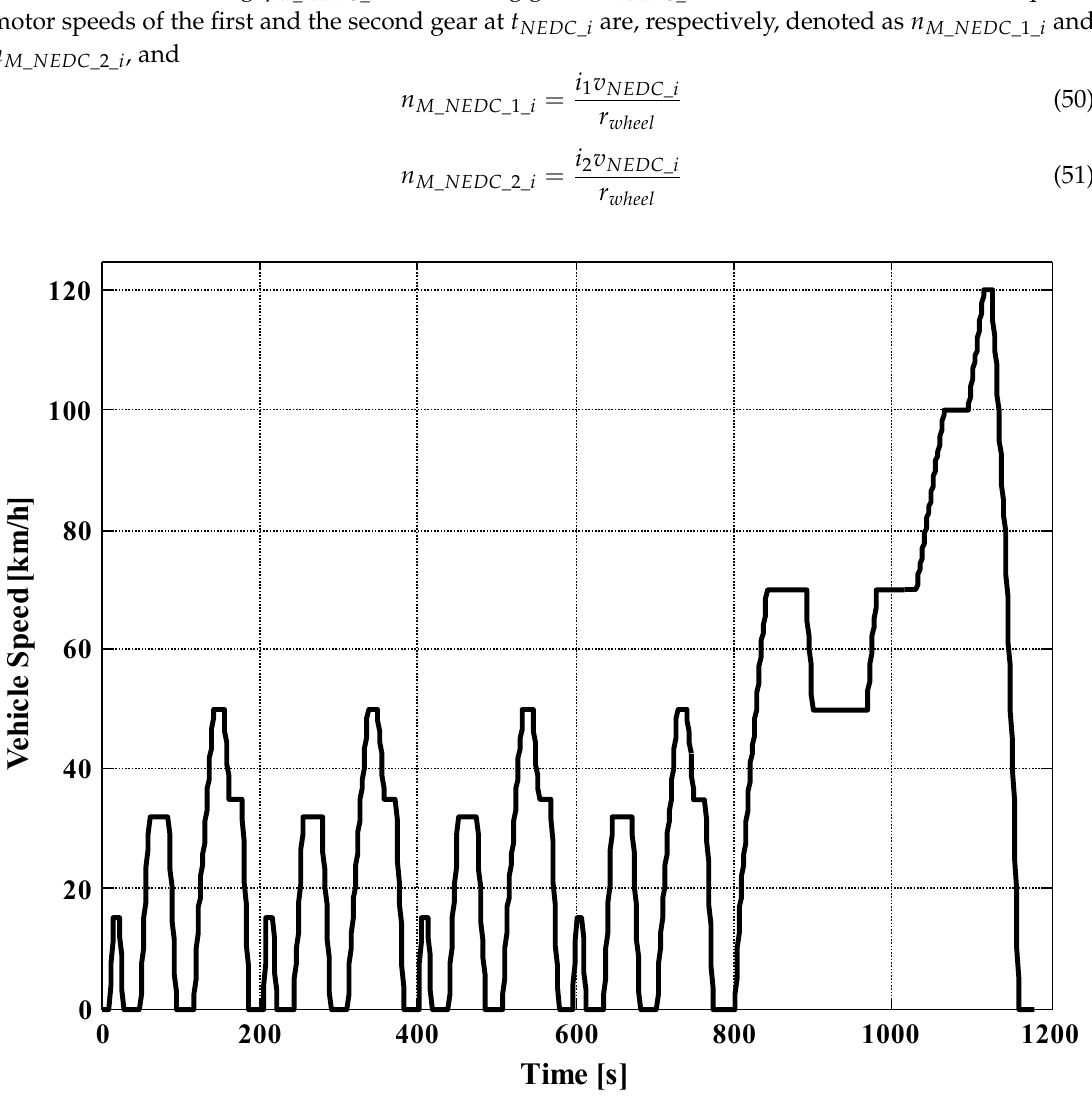
Figure 8. New European Driving Cycle (NEDC).